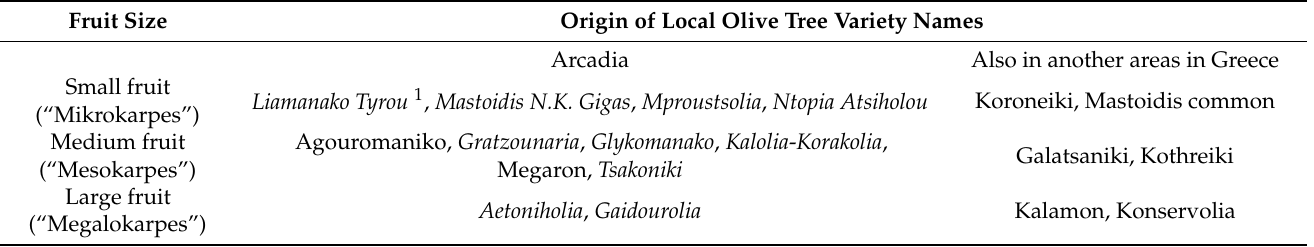
Table 8. Olive oil varieties in Arcadia using as criterion the size of the fruit and the origin (adapted from [101]). Fruit Size Origin of Local Olive Tree Variety Names Arcadia Also in another areas in